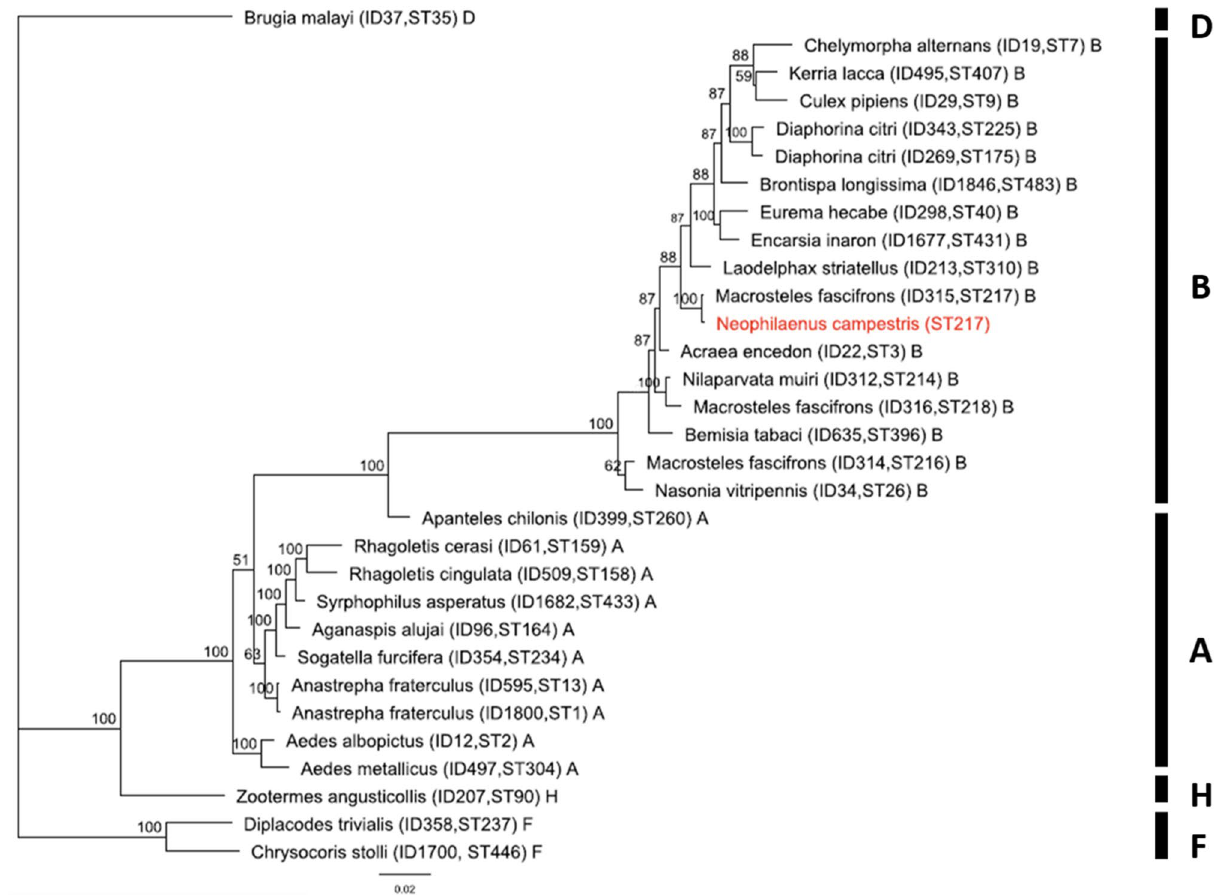
Figure 6. Bayesian Inference phylogeny based on the concatenated MLST data (2079 bp) of Wolbachia strains representing supergroups A. B. F and H. The strain of Wolbachia identified in this study is indicated in red color. Bayesian Inference posterior probabilities (%) are shown next to the branches. Capital letters indicate Wolbachia supergroups. The labels on the leaves correspond to Wolbachia strain names. Strains are characterized by the names of their host species, their IDs, the ST number from the MLST database and the supergroup they belong. Wolbachia supergroups are given to the right of the host species names. Supergroup D has been used as